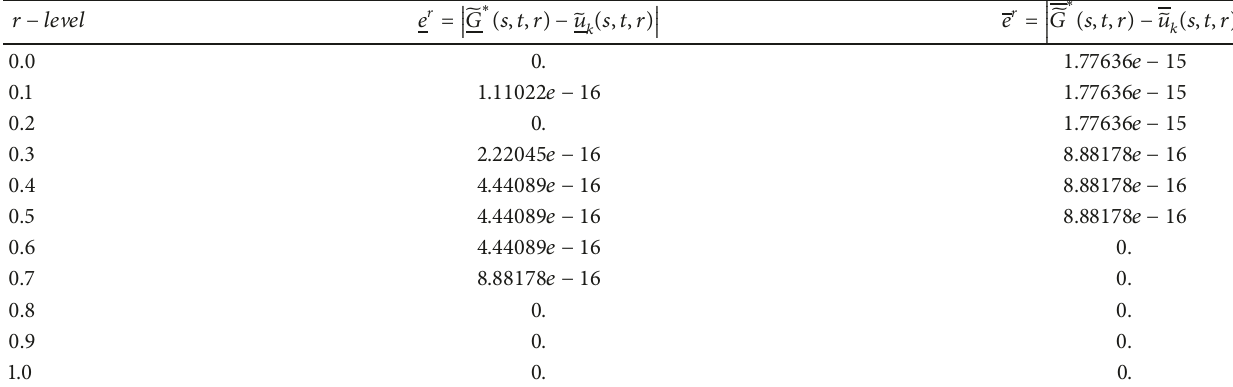
Table 2: The absolute errors on the level sets with 𝑛 = 2 , 𝑘 = 16 for Example 13 by using the proposed method in (𝑠,𝑡) = (0.5,0.5) . 𝑟 − 𝑙𝑒 V 𝑒𝑙